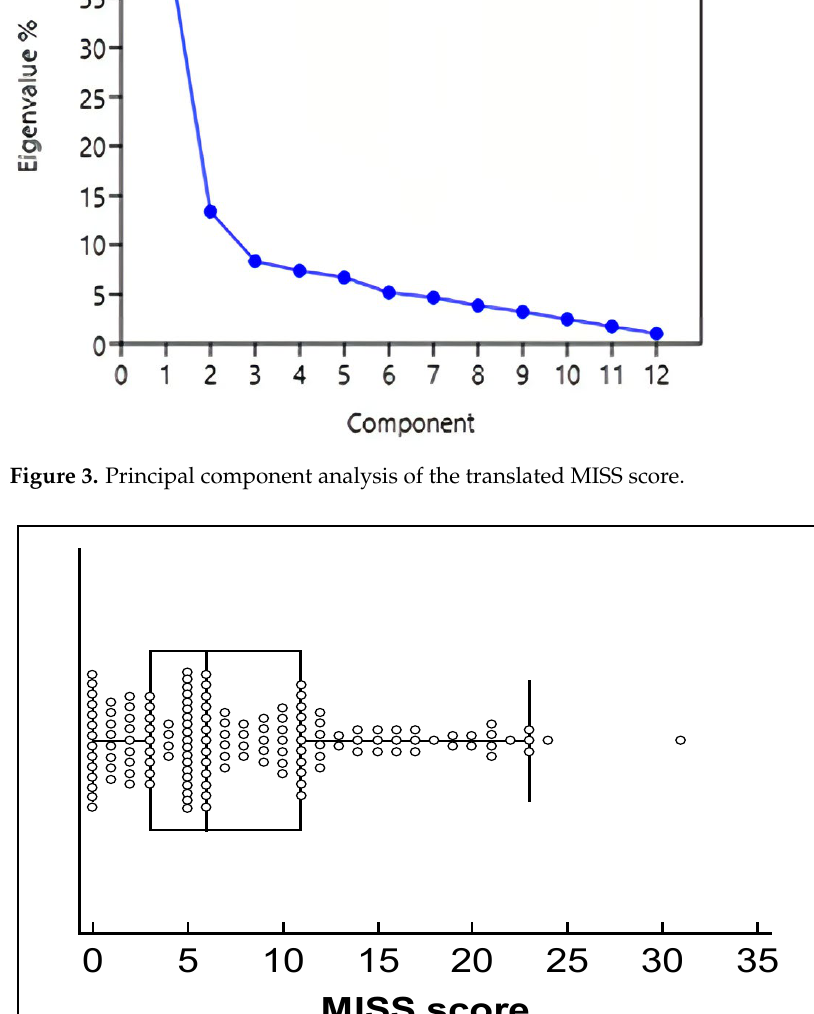
Figure 3. Principal component analysis of the translated MISS score.